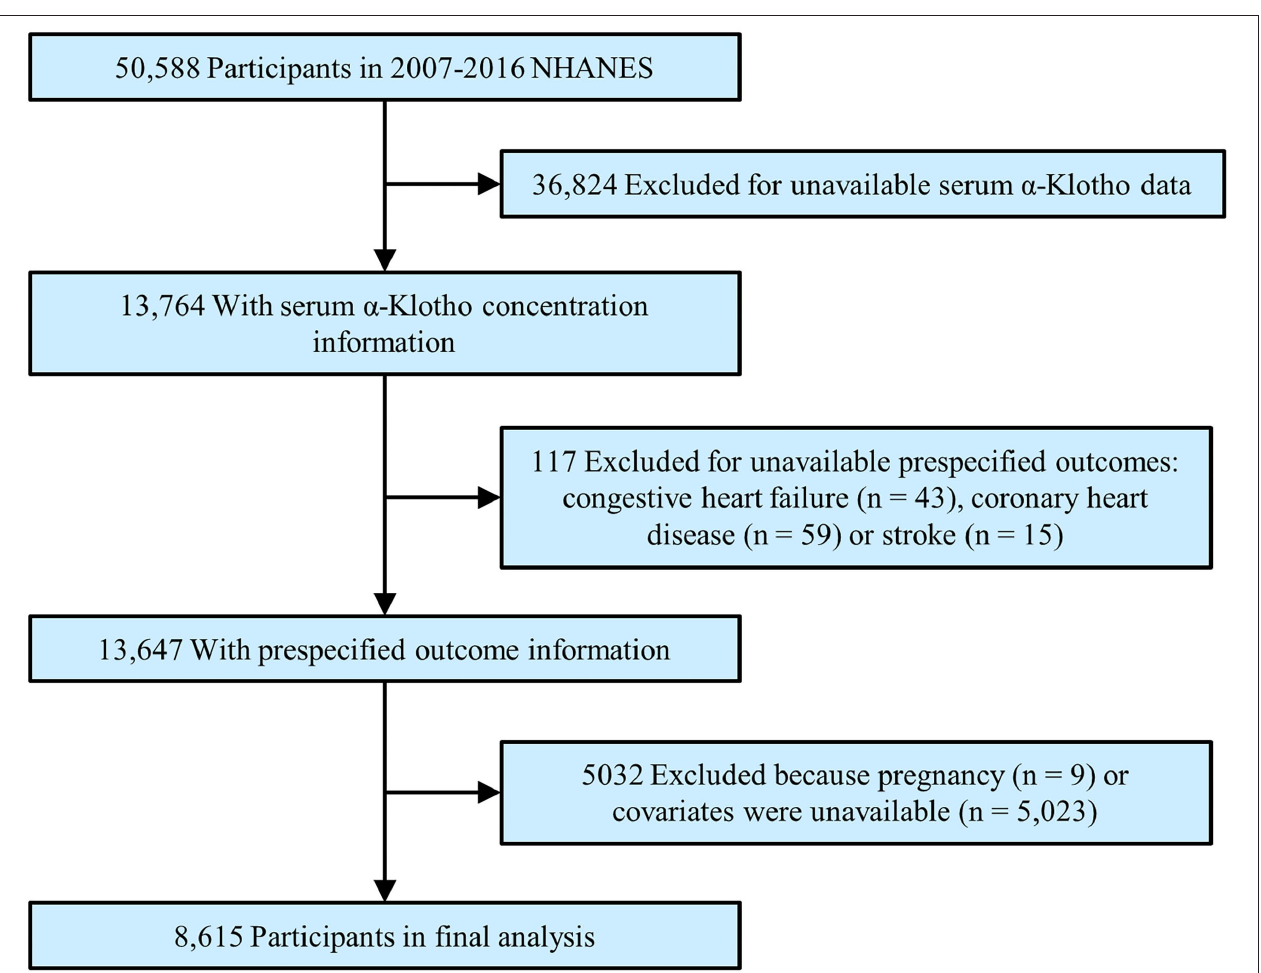
FIGURE 1 | Study flowchart. Flow chart showing the process of participant selection. Of the 50,588 participants in the 2007 to 2016 National Health and Nutrition Examination Survey (NHANES), 8,615 remained in the final